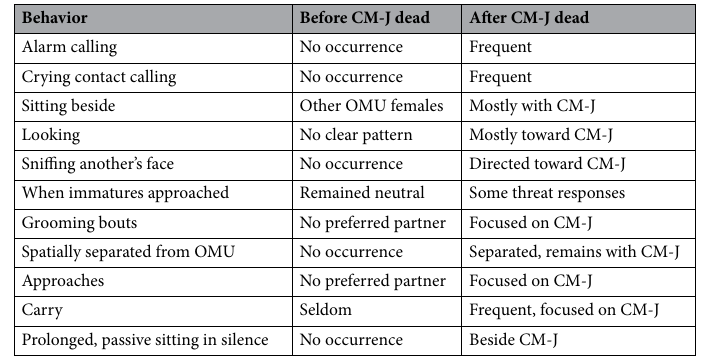
Table 1. Comparison of mother’s behavior before and after the day that CM-J